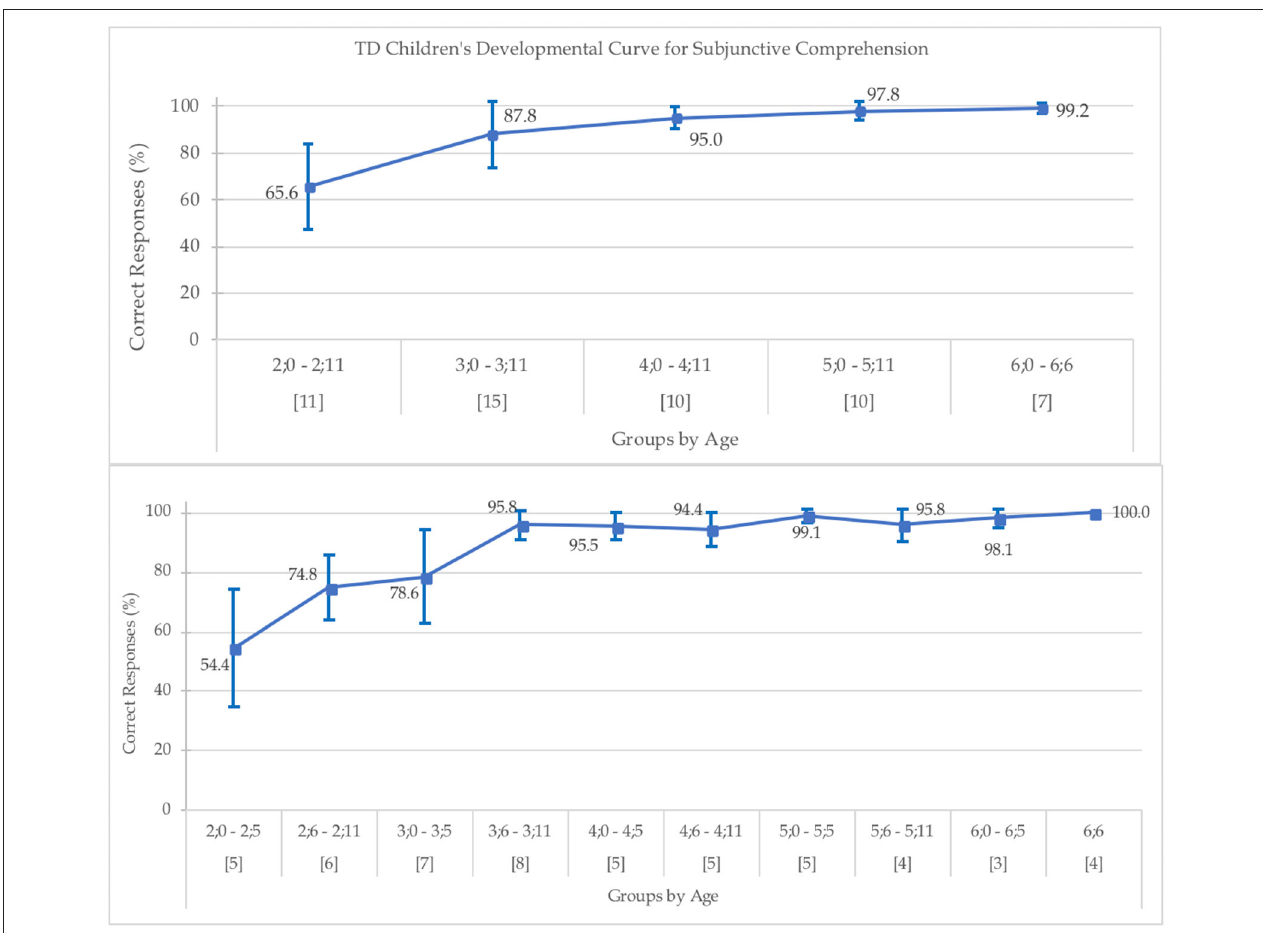
FIGURE 5 | Developmental Trajectory of the comprehension of subjunctive clauses in TD